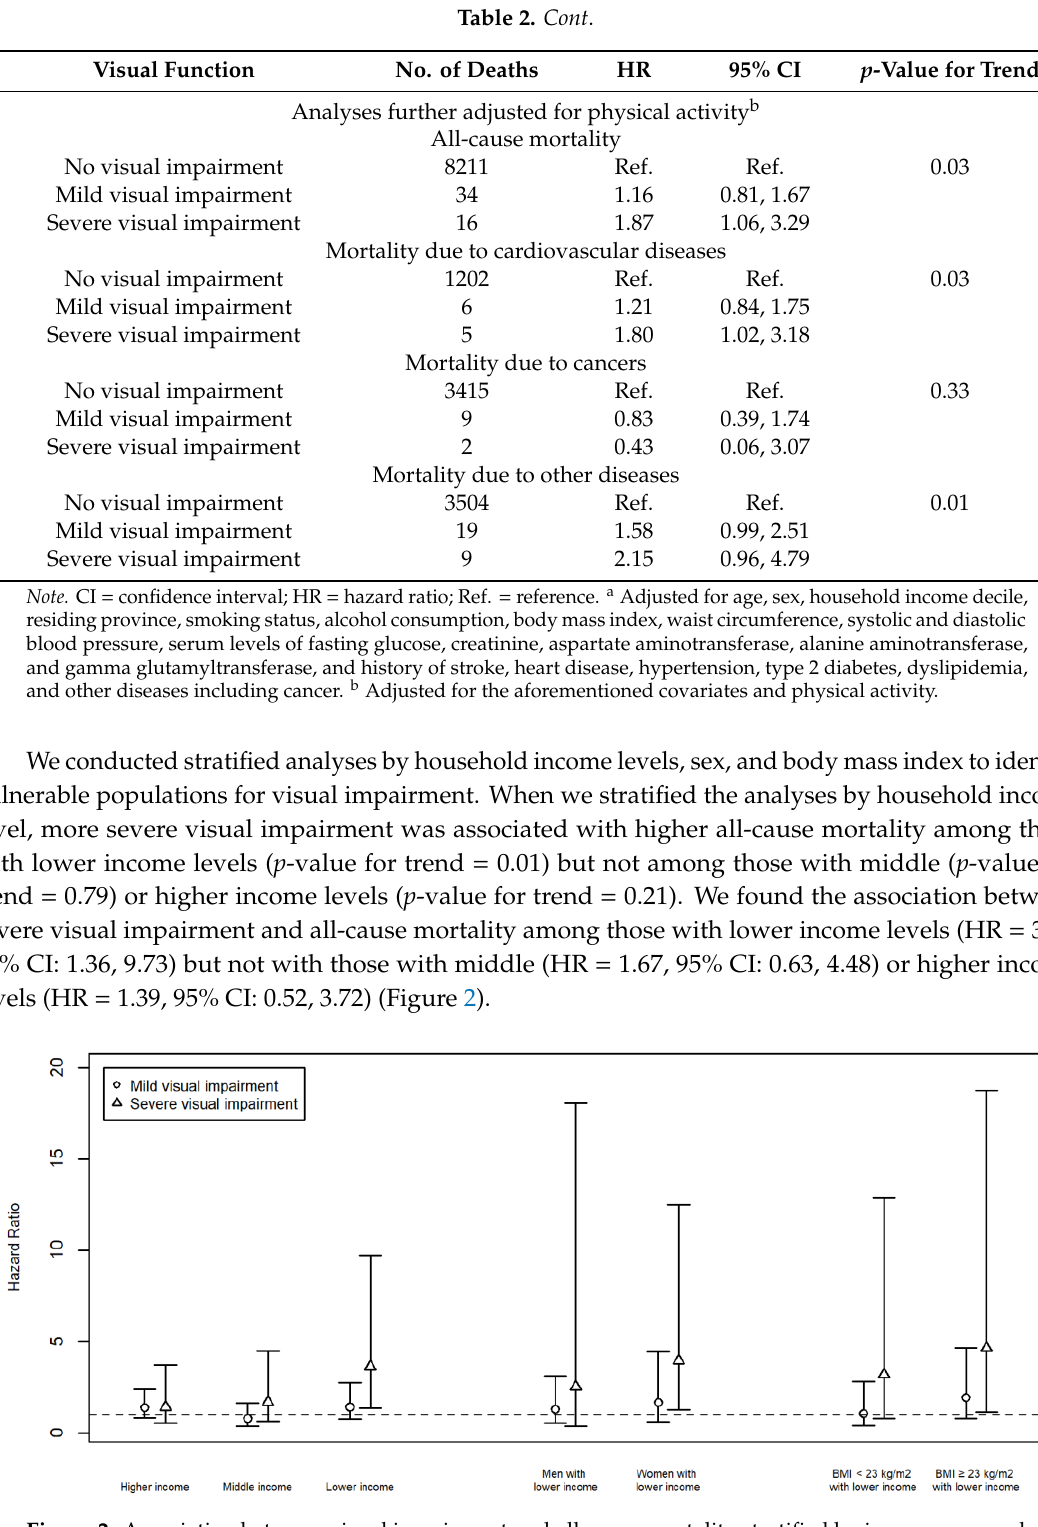
Figure 2. Association between visual impairment and all-cause mortality stratified by income, sex, and body mass index.